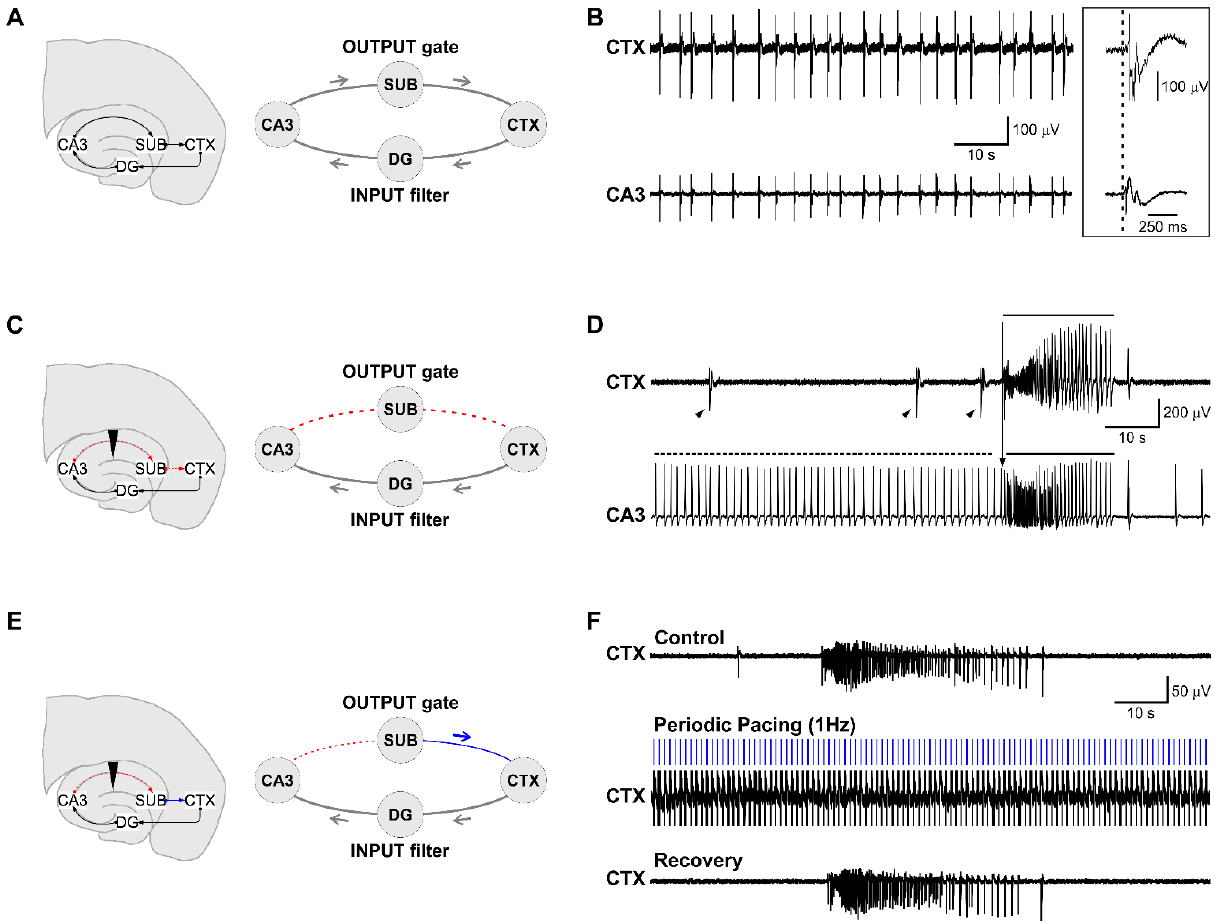
Figure 1. Network interactions in limbic ictogenesis in vitro. Epileptiform patterns induced in mouse brain slices by 4AP and recorded with MEA. ( A ) Intact brain slice. Schematic representation of the hippocampus-CTX slice and corresponding circuit diagram ( B ) Representative MEA recording showing the absence of ictal activity and the origin of the fast interictal pattern in the CA3 (boxed insert). ( C ) Partially disconnected brain slice schematic and corresponding circuit diagram. The Schaffer collaterals disruption is indicated by the dashed red line and the downward triangle. ( D ) Representative MEA recording showing that ictal activity (solid line) is generated by the CTX and re-enters the hippocampus (downward arrow). The interictal activity comprises a slow (arrowheads) and fast CA3-driven pattern (dashed line, also illustrated in ( A )), the latter here restricted to the CA3. ( E ) Partially disconnected brain slice schematic representation and corresponding circuit diagram. ( F ) Representative MEA recording showing abolishment of ictal discharges during periodic pacing at 1 Hz and re-establishment of ictal activity upon stimulus withdrawal. CA3: Cornu Ammonis 3; DG: dentate gyrus; SUB: subiculum; CTX: parahippocampal cortex.